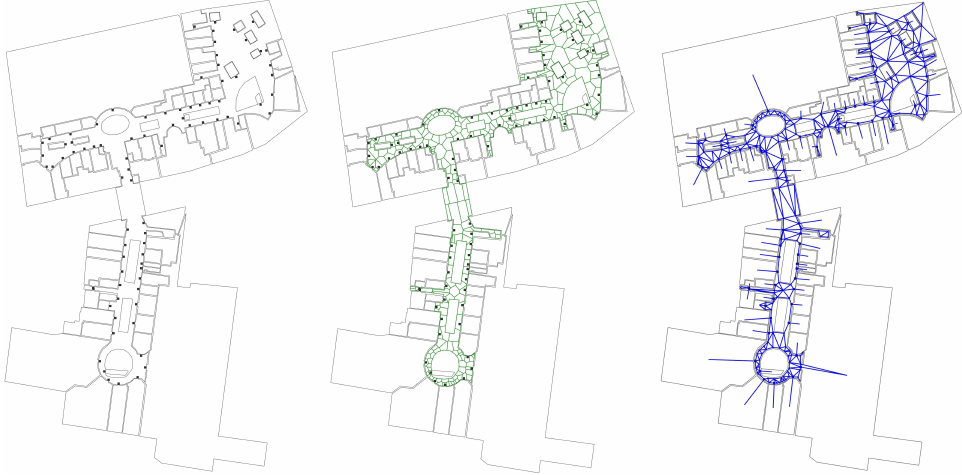
Figure 5. The floor plan, QR codes, space subdivision, and navigation network derivation of the selected floor. Black squares are QR codes, green lines in the left figure are split lines, blue lines in the right figure are edges of navigation